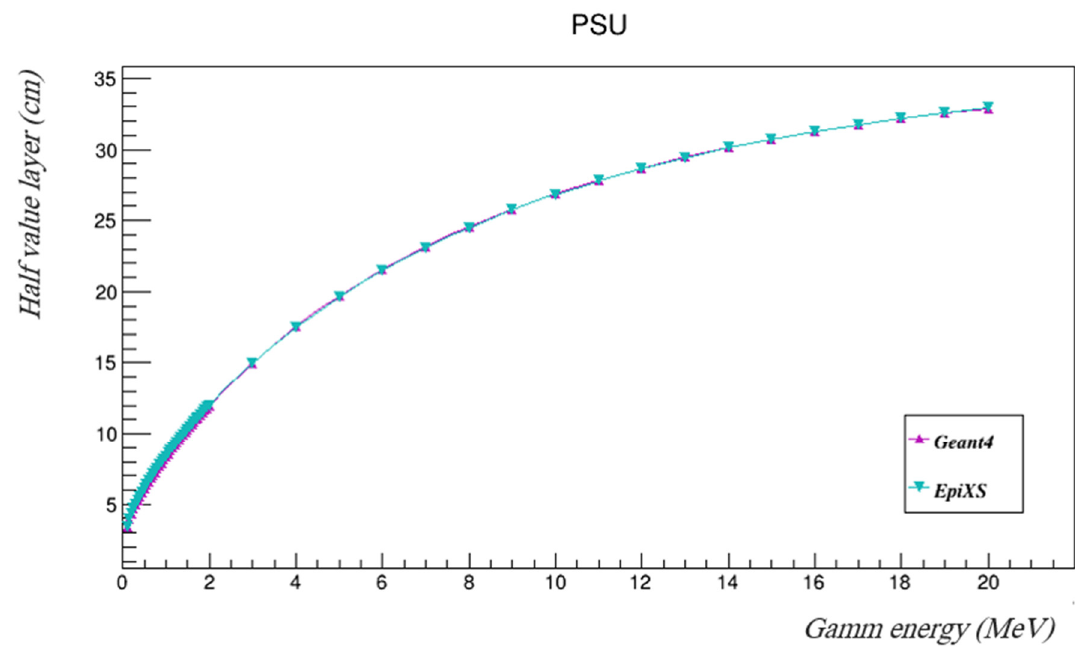
Figure 4. The half-value layers of PSU in the investigated gamma energies using both Geant4 and EpiXS. Table 4. The effective atomic numbers of PSU in the investigated energy